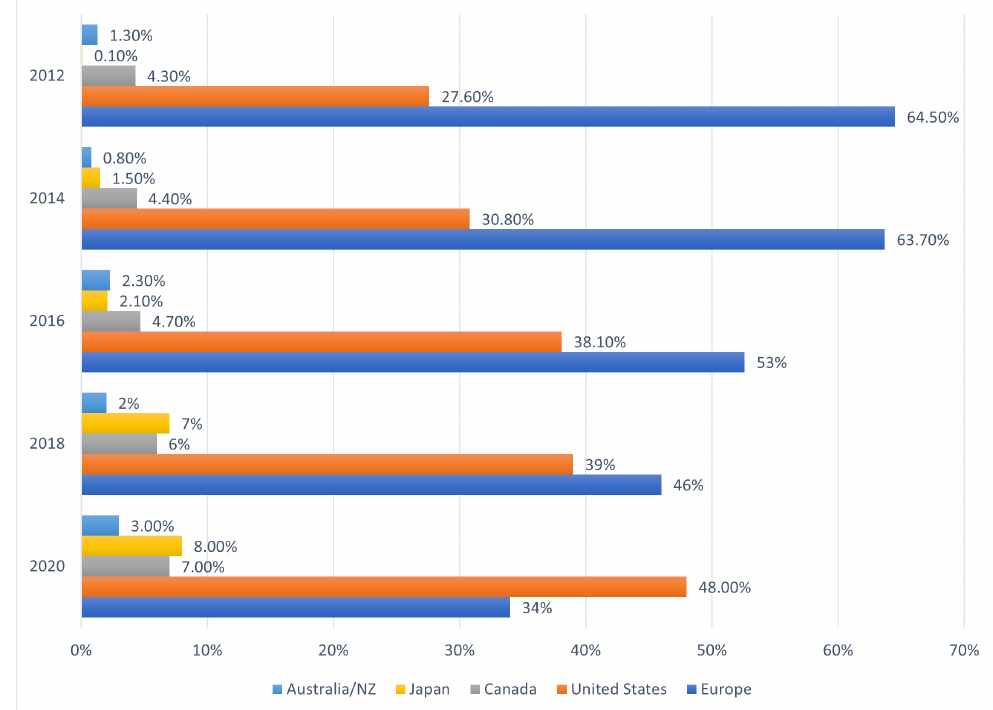
Figure A4. Proportion of global SRI assets by region 2012–2020.